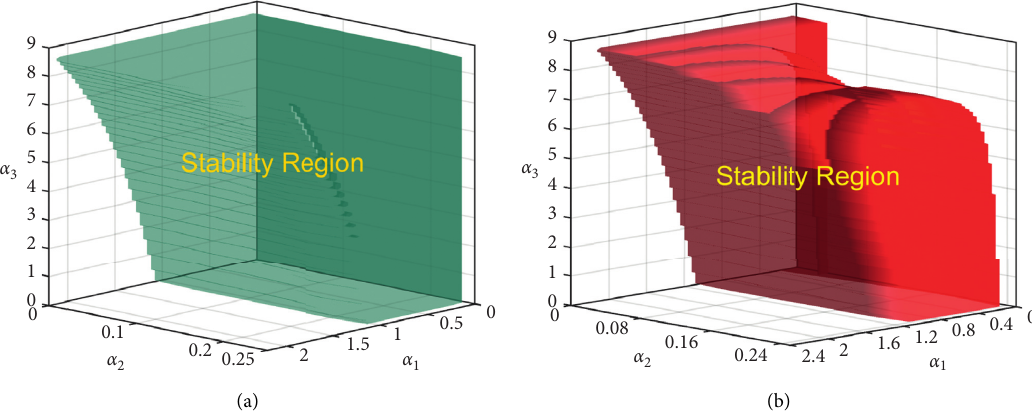
Figure 14: The stability region of E